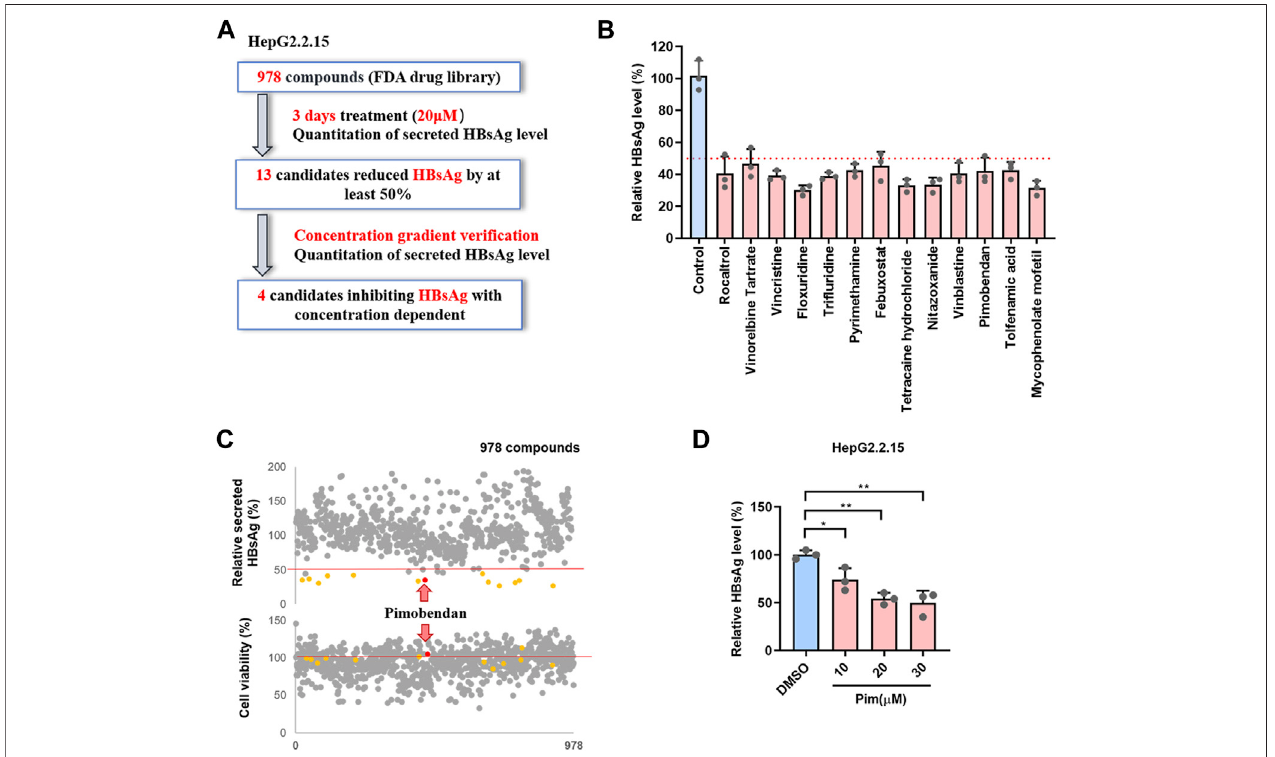
FIGURE 1 | Screening of FDA-approved compounds as potential HBsAg inhibitors (A) Schematic depiction of a screen of FDA-approved compound library. HepG2.2.15 cells were treated with 978 FDA-approved drugs (20 μ M) for 3 days, the secreted HBsAg level was quantitated (B) The 13 candidates suppressed HBsAg wastested byELISA (C) TheeffectsofallcompoundsonthesupernatantHBsAgofHepG2.2.15weredetected byELISA,and theeffectsoncellviabilityofHepG2.2.15 were detected by MTT (D) Pim inhibited the supernatant HBsAg in a dose dependent was detected by ELISA.